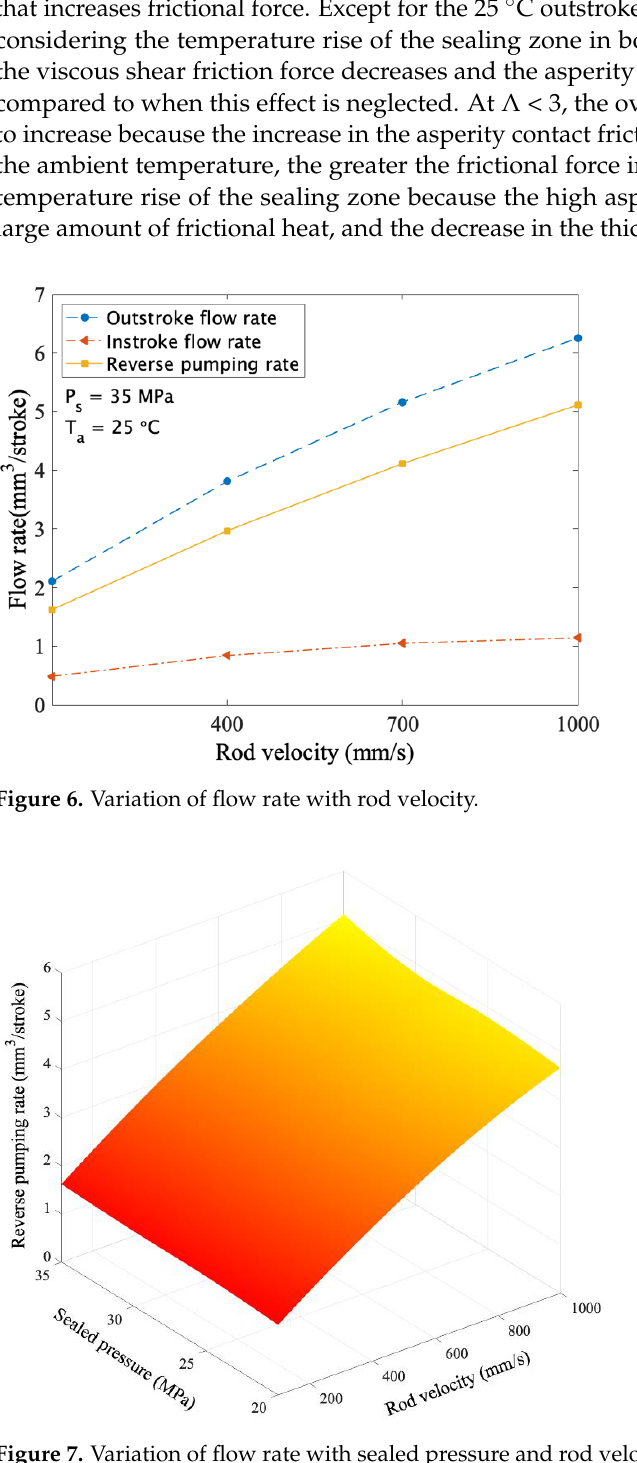
Figure 7. Variation of flow rate with sealed pressure and rod velocity .